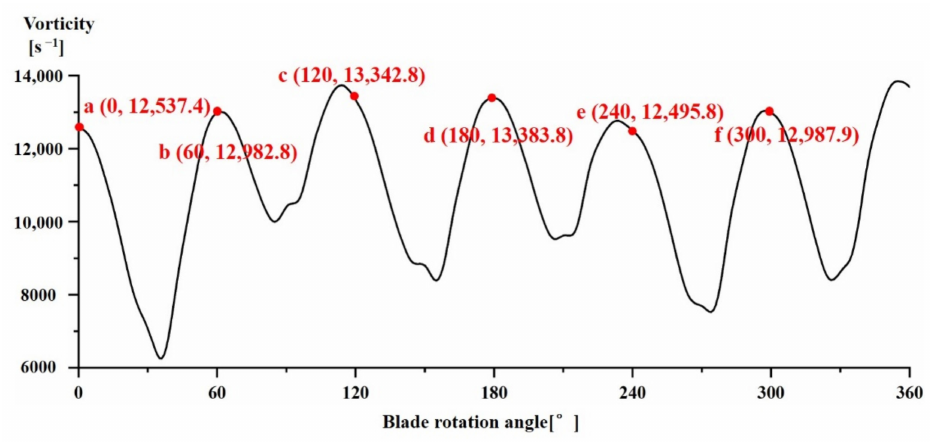
Figure 11. Vorticity of monitoring point V9 variation with